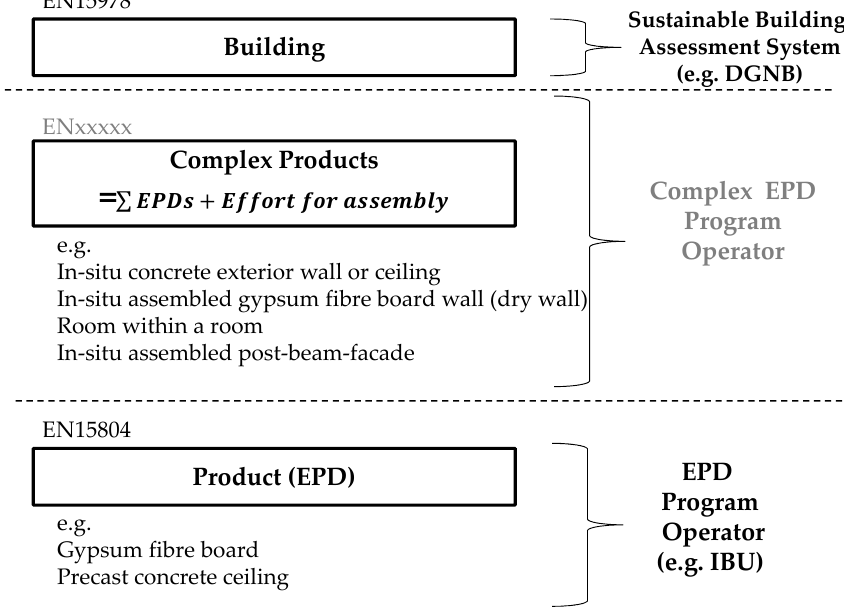
Figure 4. Current framework of standards with regard to the different levels of EPD data, depicting the gap between product EPDs and building